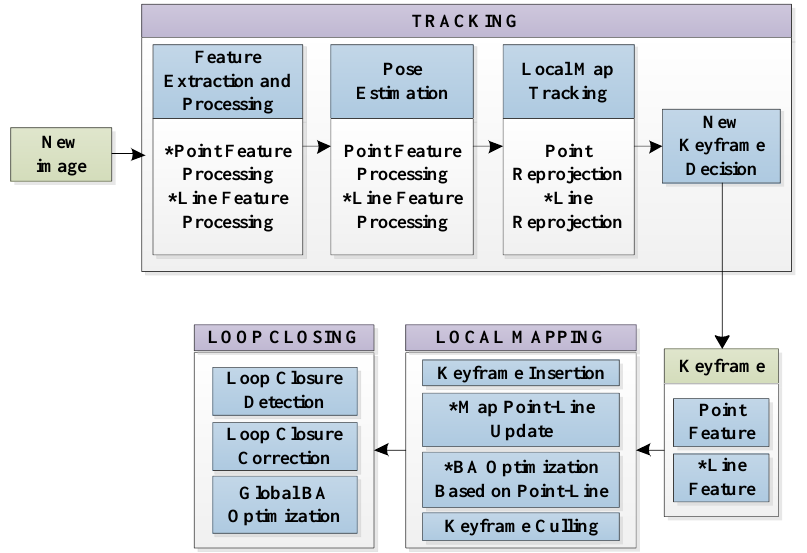
Figure 3. System overview. Our system pipeline is an extension of ORB-SLAM. The system is completed by three parallel threads: tracking, local mapping, and loop closure. Compared with ORB-SLAM, the main improvements of our system have been marked with “*” in the flowchart.